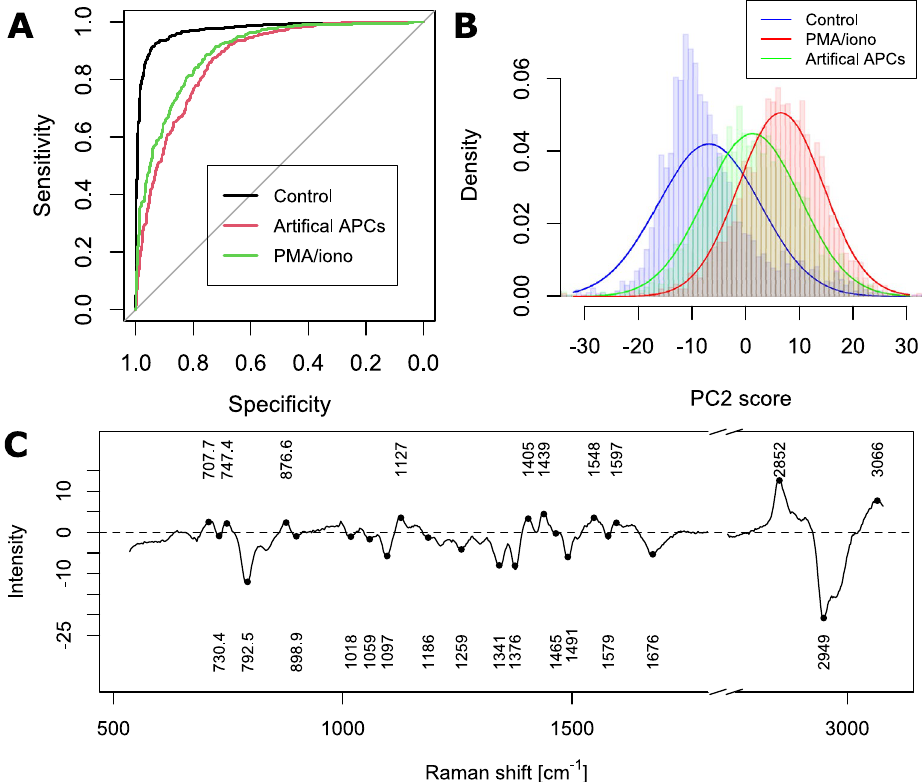
Figure 2. Detection of T cell activation. Cells activated through chemical means or TCR stimulation are compared to resting (unstimulated) cells. (N = 2500 per class for training) ( A ) ROC curve of classification performance. ( B ) Single-cell populations distribution along the PCA scores of PC2, which contains most of the variance related to activation. ( C ) Loading vector of PC2.